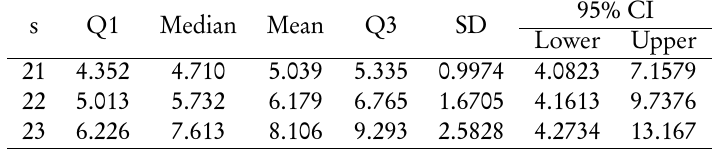
Sample based summary for one sample predictive posterior based on Scheme 1 for real data set.